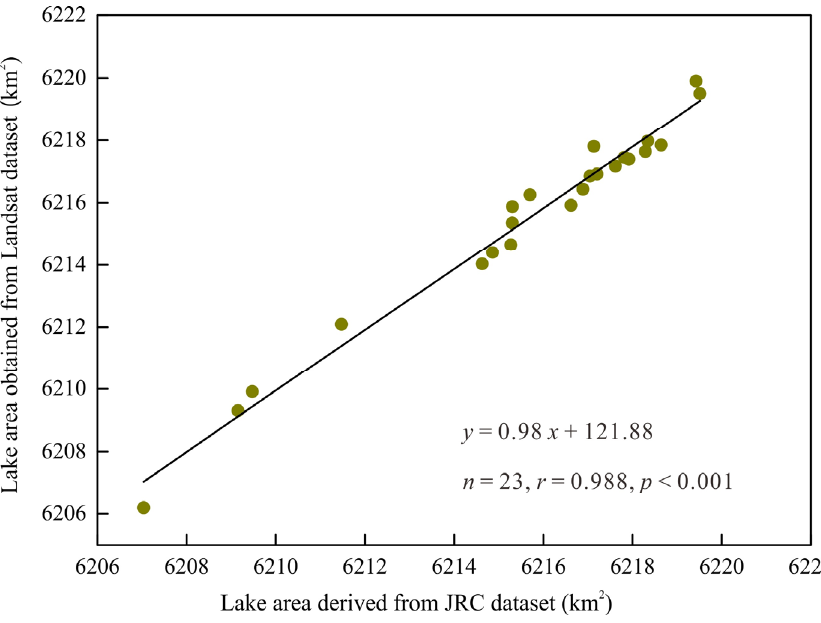
Figure 10. The comparison between the extraction results of the JRC dataset and the Landsat dataset using the mNDWI and OTSU algorithm.